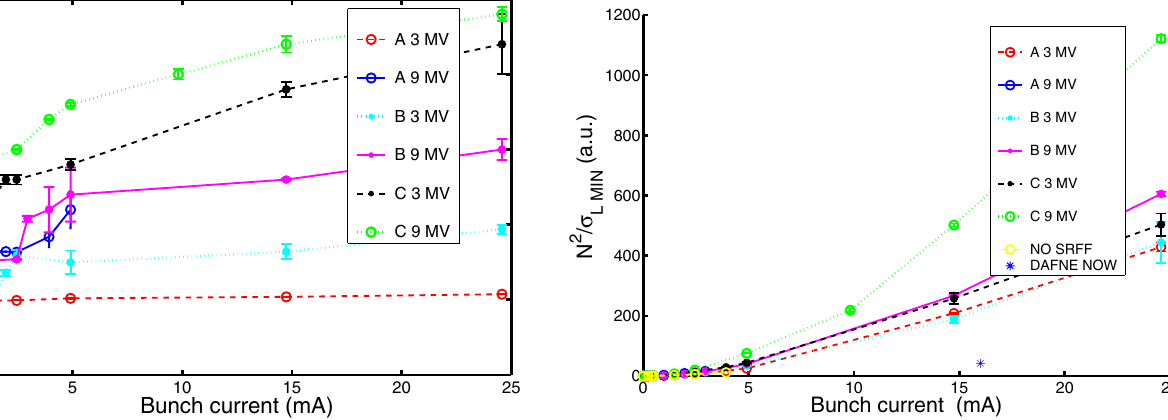
FIG. 15. (Color) Energy spread as a function of current up to 25 mA, under the effect of the CSR wakefields only.